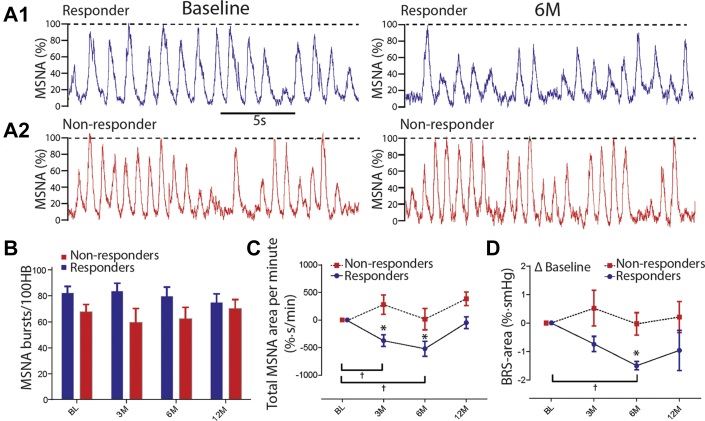
Sympathetic Activity and its Baroreflex Control After uCB ResectionRepresentative raw muscle sympathetic nerve activity (MSNA) for a responder (A1) and nonresponder (A2) at baseline (left trace) and 6-month follow-up (right trace). (B) There was no difference in MSNA burst incidence between responders and nonresponders. However, MSNA area was reduced after uCB resection in the responders but not nonresponders (C), and spontaneous MSNA area baroreflex gain improved in responders but not in nonresponders (D). Two-way repeated measures analysis of variance was used (within groups *p < 0.05; between groups †p < 0.05); bursts/100HB = bursts per 100 heart beats; other abbreviations as in Figure 2.